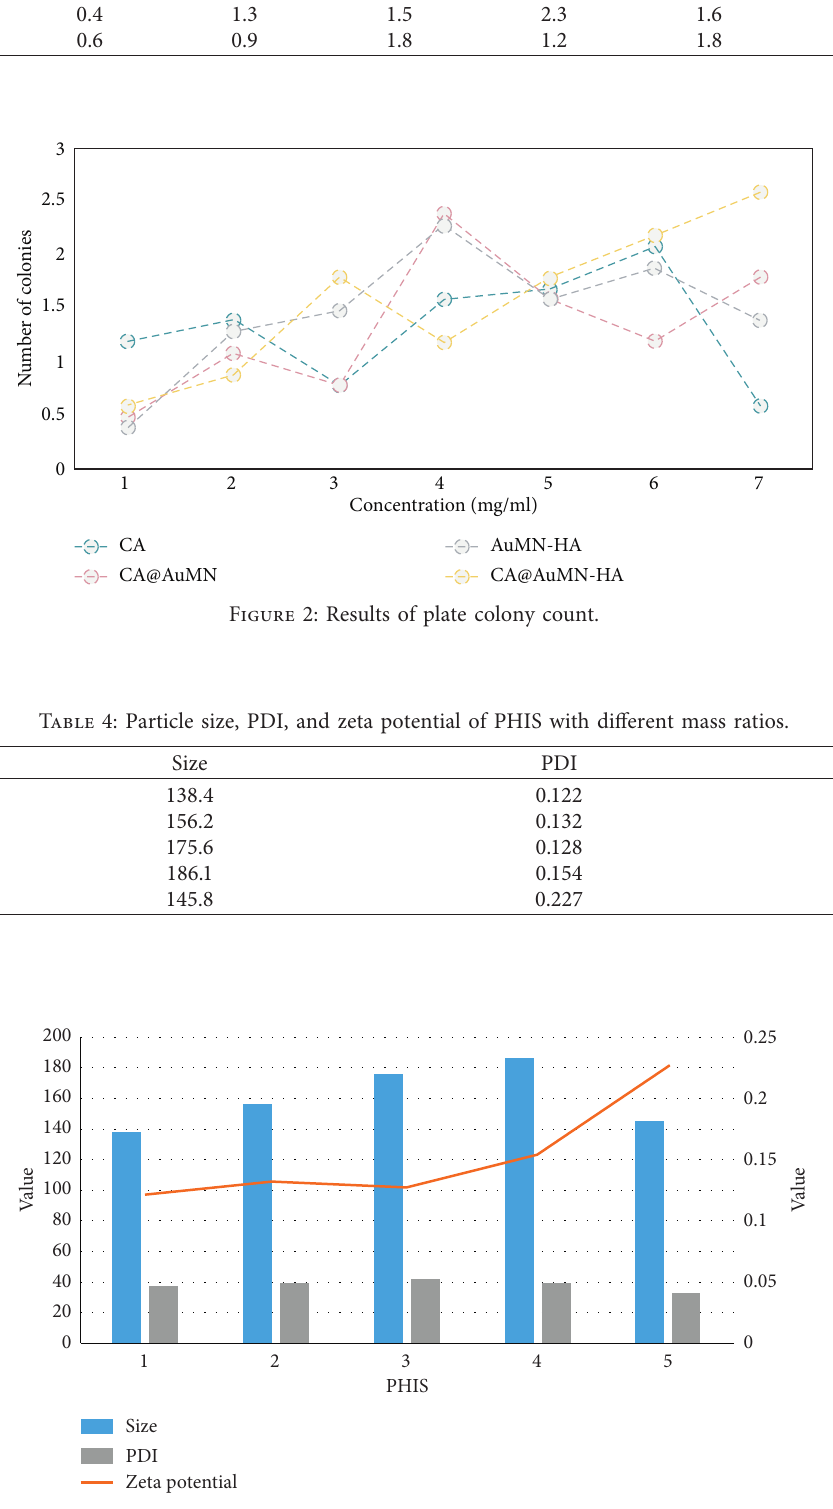
Figure 3: Particle size, PDI, and zeta potential of PHIS with different mass ratios.